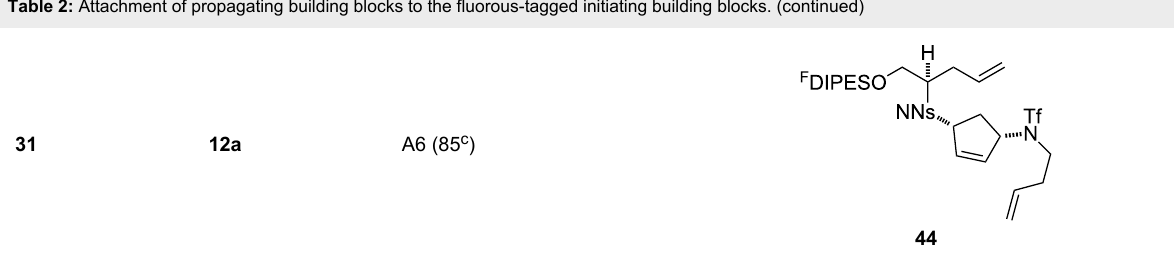
Table 2: Attachment of propagating building blocks to the fluorous-tagged initiating building blocks. (continued)